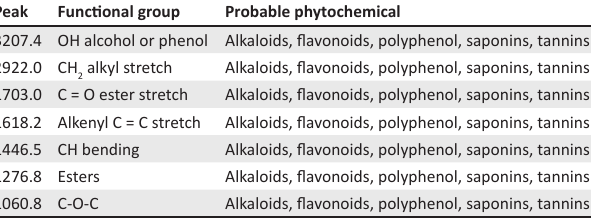
FIGURE 2: Fourier transform infrared spectra of Harrisonia abyssinica TABLE 2: Major peaks in Fourier transform infrared spectra of Prunus africana bark extracts.